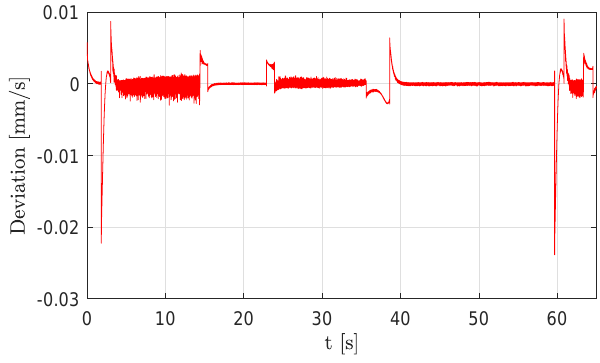
Figure 16: EMC drivetrain speed deviation. The simulated EMC drivetrain displacement x EMC is compared in Figure 13 against the displacement of the EHC logged from the offshore rig in operation.